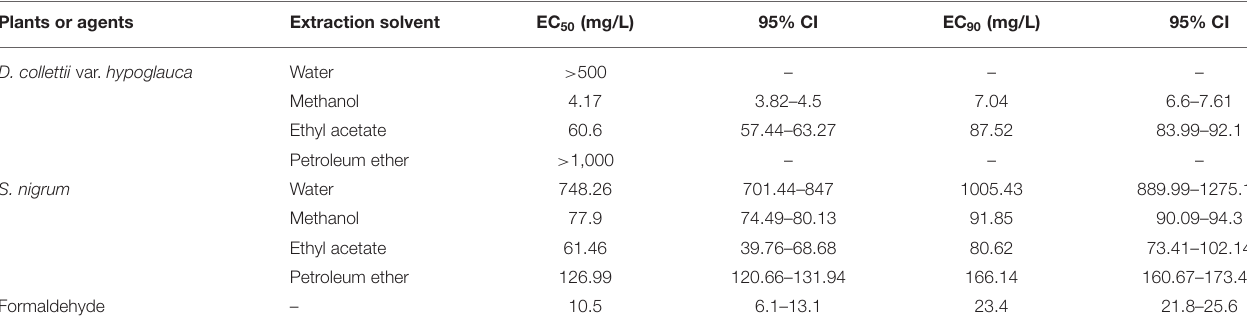
TABLE 2 | Antiparasitic efficacy (EC 50 and EC 90 ) of different extracts from Dioscorea collettii var. hypoglauca and Solanum nigrum against Gyrodactylus kobayashii after 48h of exposure. Plants or agents Extraction solvent